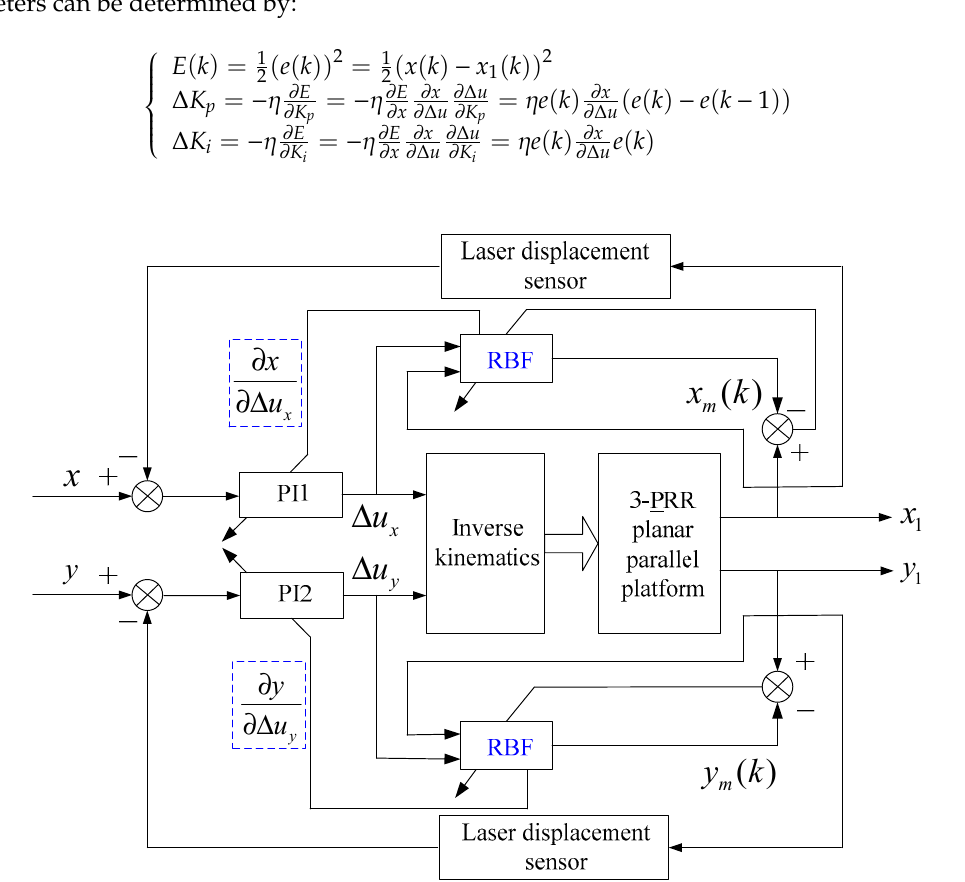
Figure 15. Radial basis function (RBF) neural network controller of the 3-PRR parallel platform.